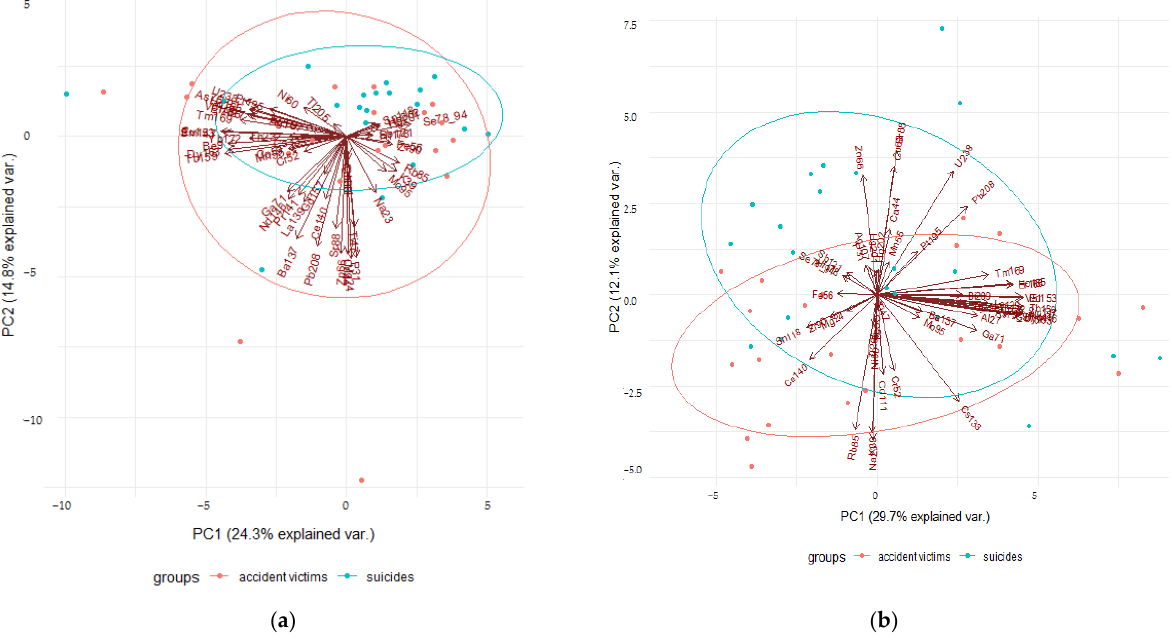
Figure 2. Principal component analysis (PCA) biplots of ICP-MS data from the dura matter ( a ), and the arachnoid mater ( b ). Only the first two principal components (PC1, PC2) are shown with their respective variation in